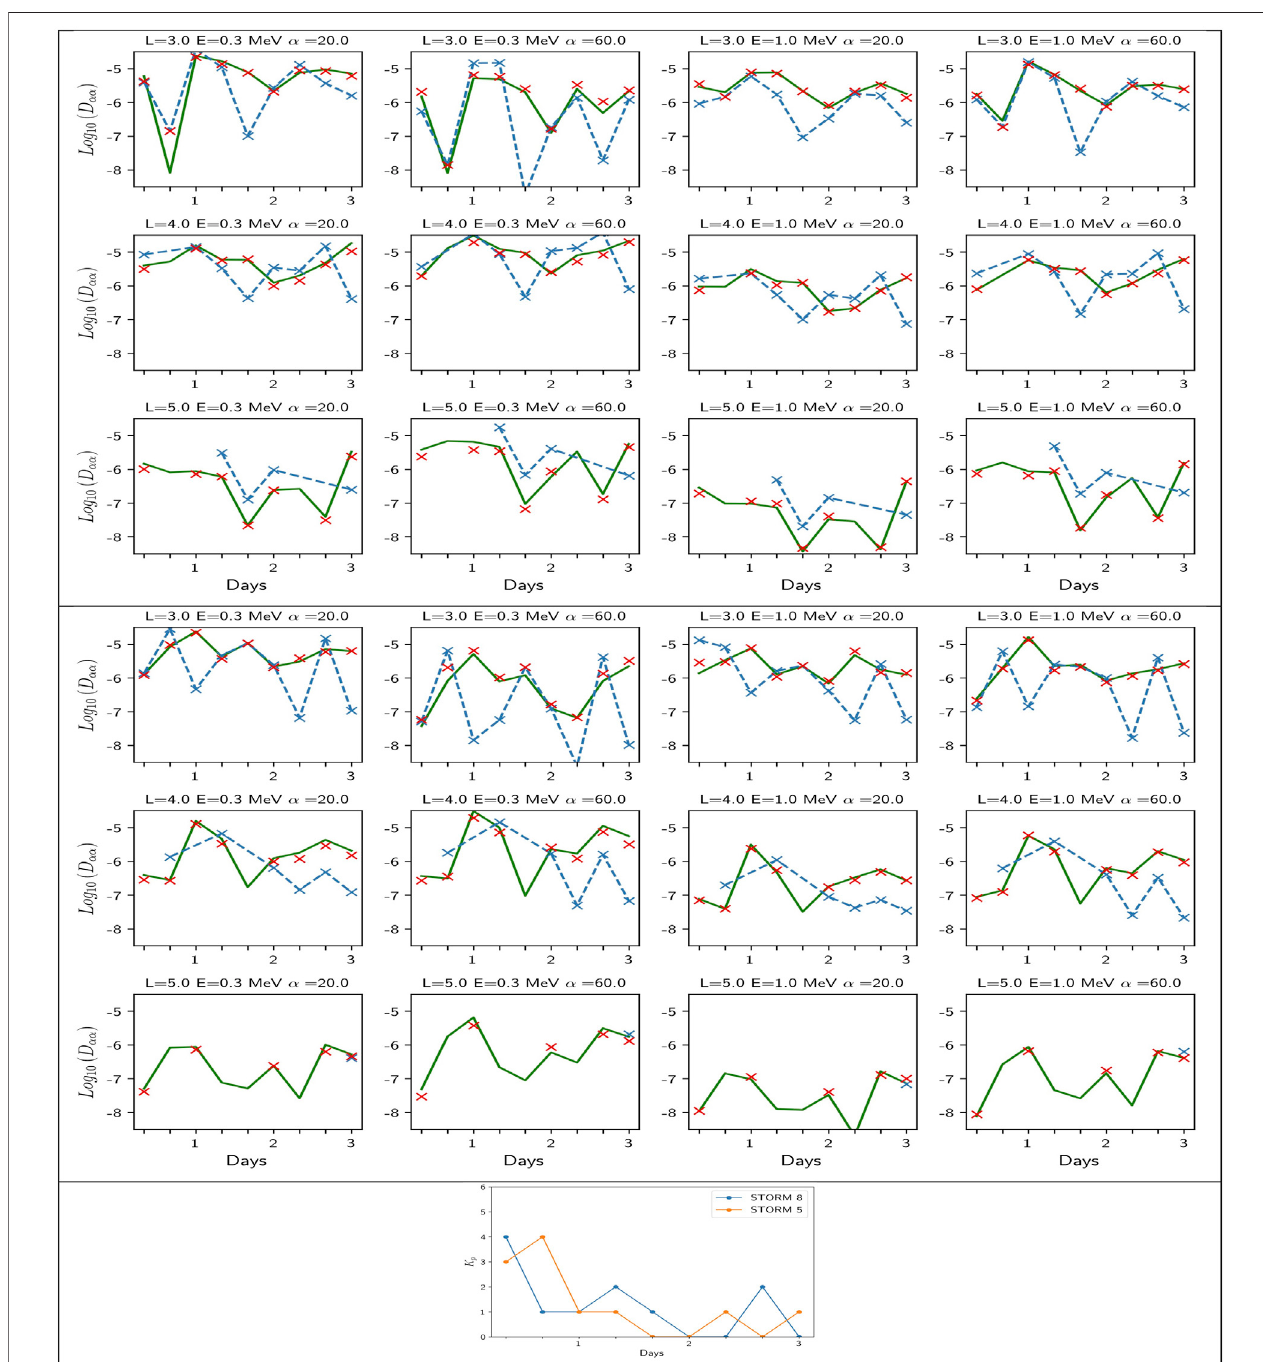
FIGURE 5 | Pitch angle diffusion coef fi cients for (1 – 3 rows) storms 8 and (4 – 6 rows) storm 5. The fi rst 6 panels show historic pitch-angle diffusion coef fi cient's at different ( L , E , α ) values, with (blue crosses and lines) the raw data of event-driven coef fi cients (red crosses) the averaged data (on the 32 storms at given ( K p , t , L , E , α )), and (green lines) the DNN model. The average data (in red) and the DNN model (in green) (trained on a subset of the average model) are run from the Kp(t) sequence of eachstormplottedatthebottompanelforeachofthe9temporalbins.ThegoodagreementbetweenredcrossesandthegreenlineshowsthesuccessoftheDNN modelat matchingitstarget.Bothcapturelevelsandvariations, butarenotveryaccuratecomparedwiththeevent-drivendiffusionreferencevaluesinblue, showingthe limits of a mean model.